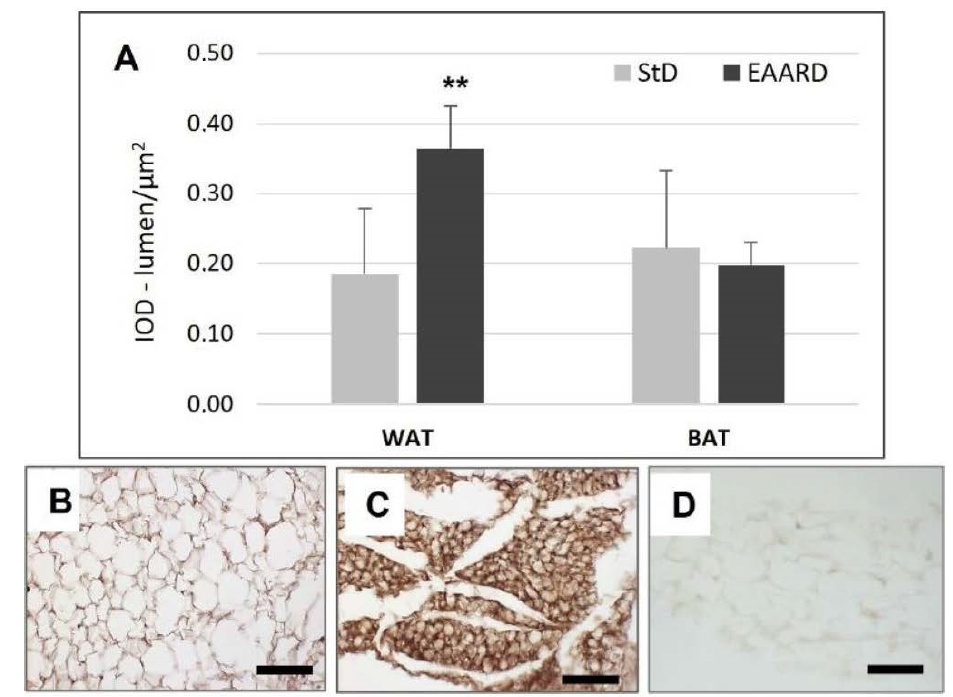
Figure 3. ( A ): Optical density for leptin immunostaining in rpWAT ( t = 3.582, p = 0.001) and BAT ( t = 0.998, p = 0.636) according to diets (mean ± sd). ** p < 0.01. ( B , C ): Representative images of rpWAT IHC in StD and EAARD-fed mice, respectively. ( D ): Negative control performed by omitting the primary antibody. Original magnification 20×; scale bar 50 μm.